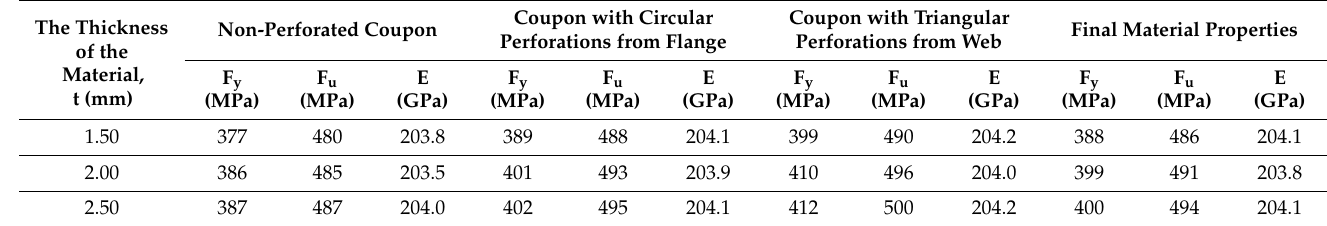
Table 1. The average mechanical properties of the tensile coupon test results.